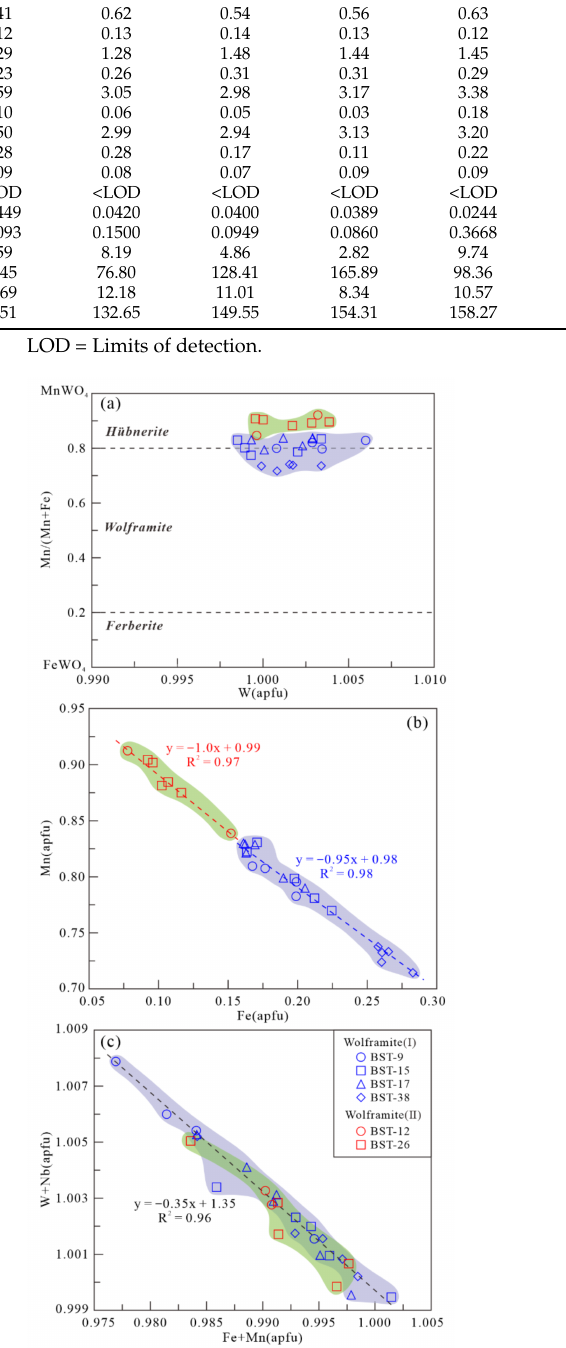
Figure 8. Chemical variations in major and trace elements in wolframite from the two mineralization stages of the Baishitouwa deposit. ( a ) Mn/(Mn + Fe) versus W diagram; ( b ) correlation between Mn and Fe contents in wolframite; ( c ) negative correlation between (W + Nb) and (Fe + Mn)